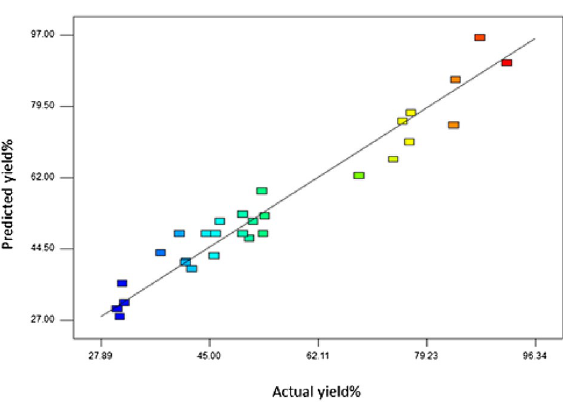
Figure 8. Relationships between the experimental and predicted